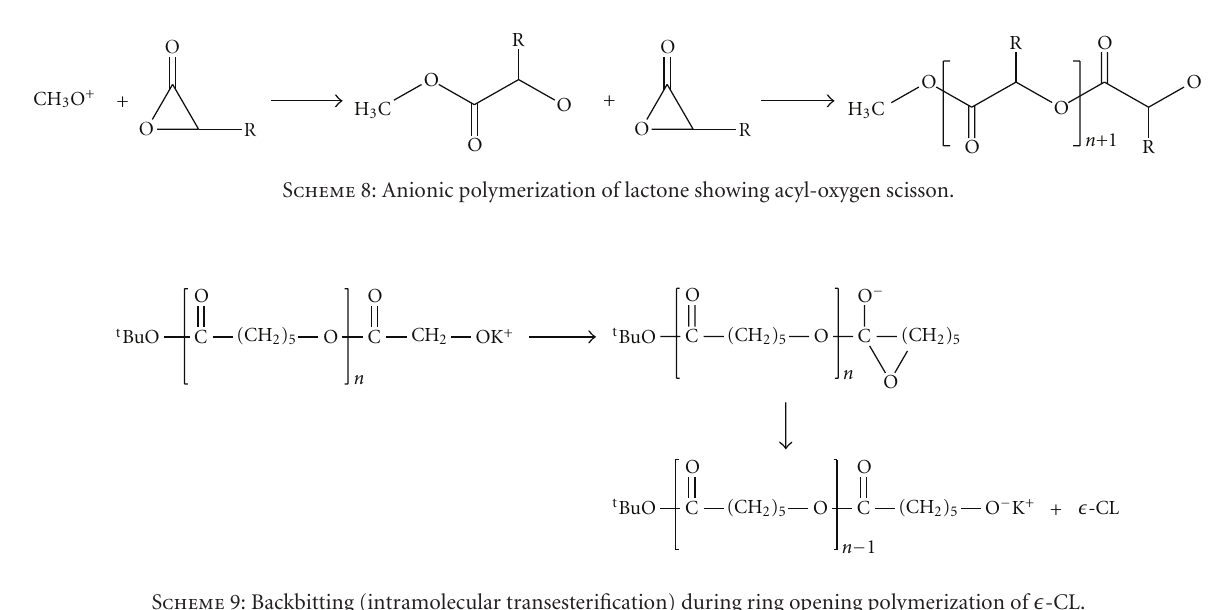
Scheme 9: Backbitting (intramolecular transesterification) during ring opening polymerization of (cid:2) -CL.